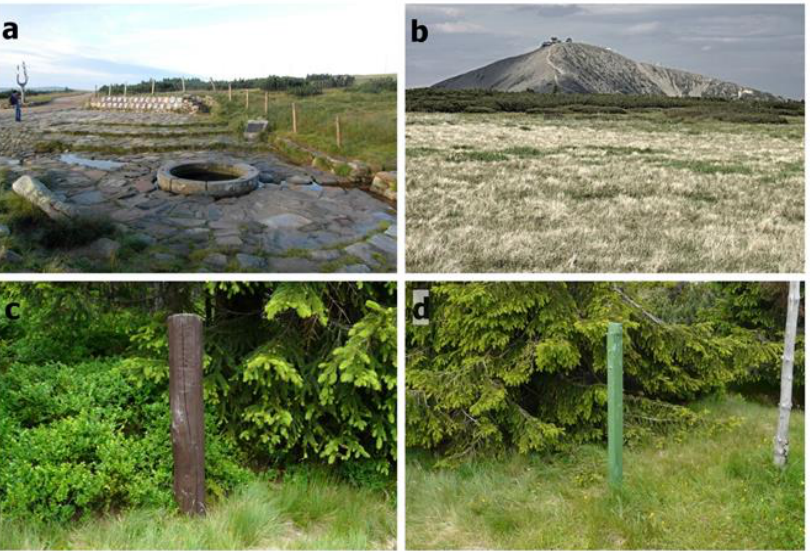
Fig. 2. The most visited sites in Krkonoše Mountains National Park (KRNAP): the Elbe River spring (a) and the highest peak, Sněžka (b). Photographs of differently designed on-site counters located in KRNAP, both use PYRO temperature change sensors (c, d)